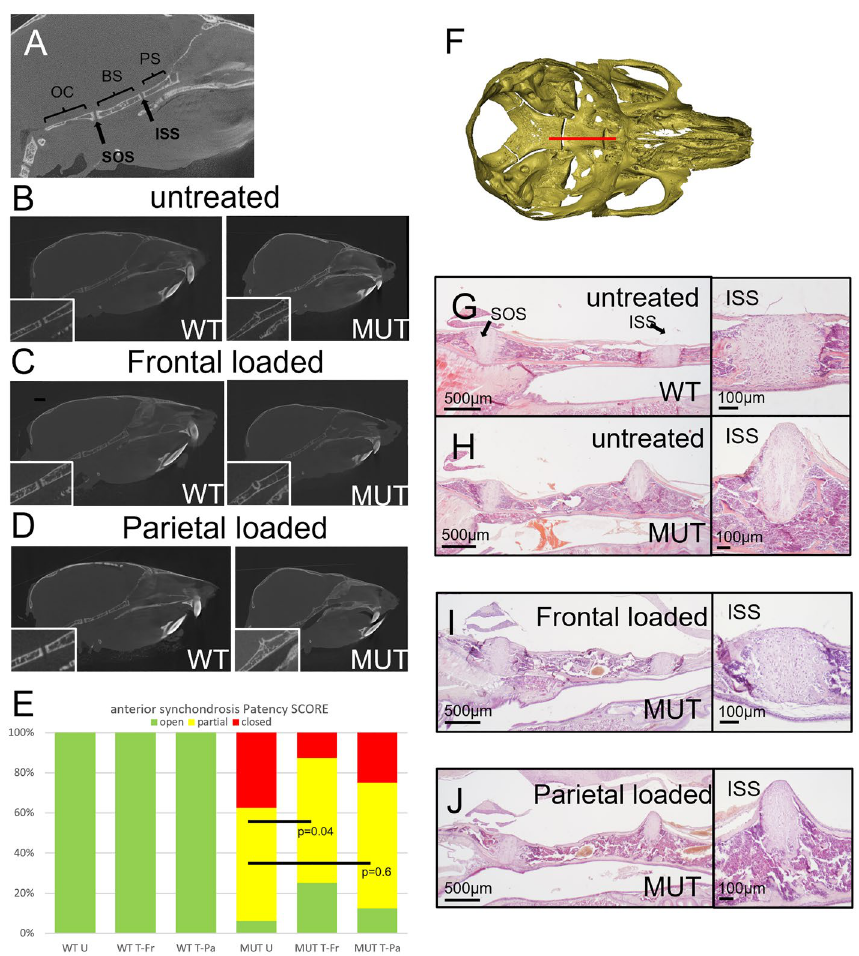
Figure 4. Changes in skull base morphology and histology following cranial bone loading. ( A ) Schematic of the skull base showing anatomical structures. OC occipital, BS basi-sphenoid, PS pre-sphenoid, SOS spheno- occipital synchondrosis, ISS intersphenoidal synchondrosis. ( B – D ) Micro-CT images of sagittal, midline sections through the skull. Untreated WT skulls show a fully patent ISS (inset) while MUT synchondroses have closed ( B ). Frontal loaded skulls show improved patency of the ISS ( C ), while parietal loaded skulls do not ( D ). ( E ) Patency of the anterior synchondrosis (ISS) was scored blinded for sample identity. While all WT synchondroses are open (green) at P21, the majority of the untreated MUT skull bases have a partially (yellow) or fully closed (red) ISS. Skulls loaded on the frontal bone show a statistically significant improvement while parietal loaded skulls do not. Untreated-WT (WT U) n = 12, frontal loaded-WT (WT T-Fr) n = 15, parietal loaded-WT (WT T-Pa) n = 9, untreated MUT (MUT U) n = 16, frontal loaded MUT (MUT T-Fr) n = 7, parietal loaded MUT (MUT T-Pa) n = 8. ( F ) Sagittal, midline sections through the skull base (red line) at P21 were stained with H&E. ( G–J ) Histological analysis of the Crouzon-associated phenotypic features following cranial loading. ( G ) A wild-type skull base showing the bones separated by synchondroses. SOS spheno-occipital synchondrosis, ISS intersphenoidal synchondrosis. The magnified image of the ISS shows a rectangular cartilage situated between endochondral bone. ( H ) Mutant (MUT) ISS shows an aberrant cone shape and the cartilage structure protrudes cranially. ( I ) Animals treated with frontal bone loading show a more normal synchondroses. ( J ) Animals treated with parietal bone loading show no improvement and look similar to untreated